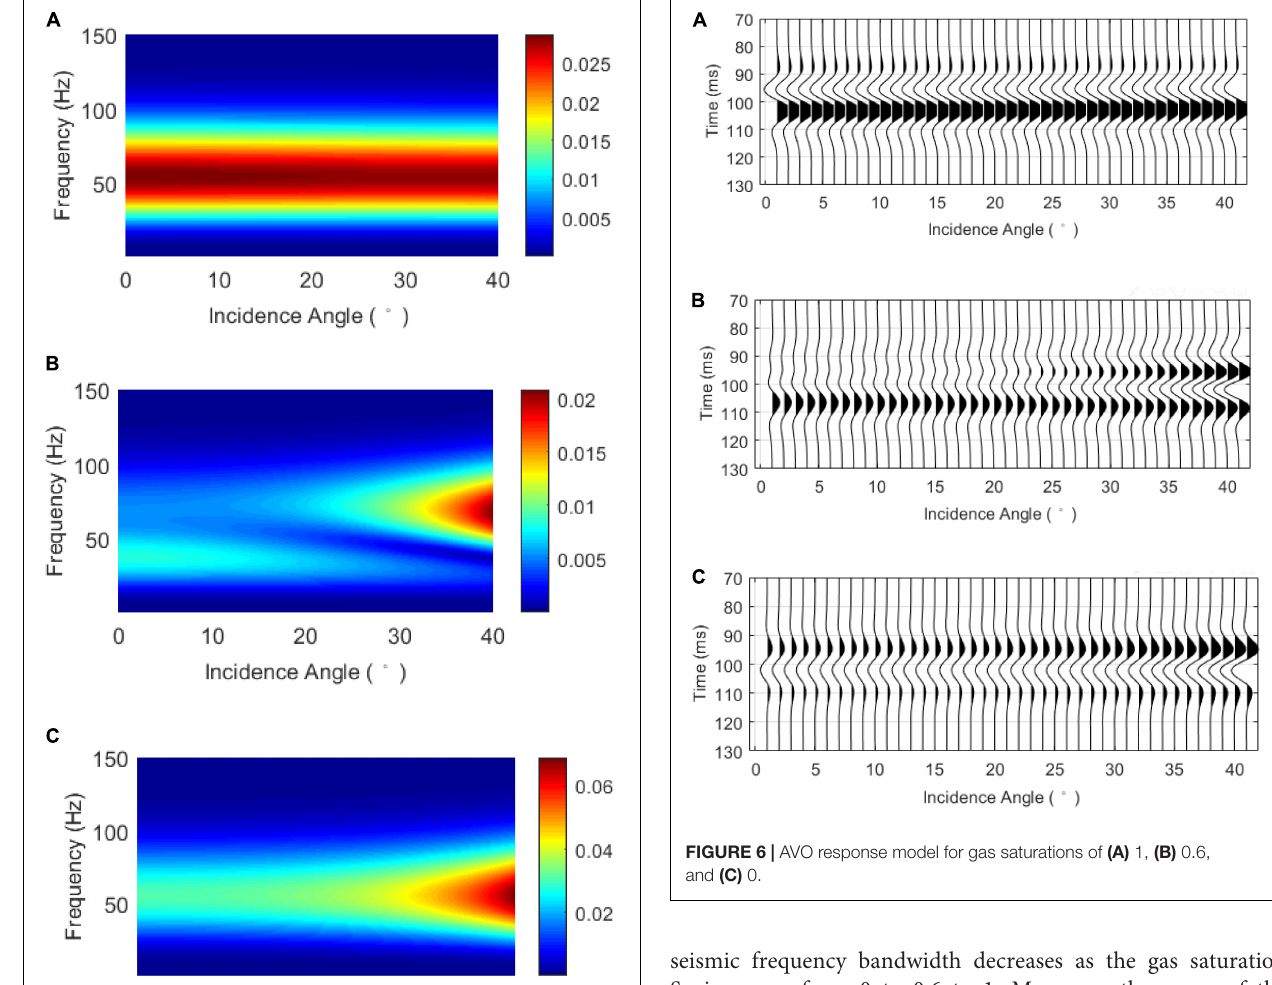
seismic frequency bandwidth decreases as the gas saturation Sg increases from 0 to 0.6 to 1. Moreover, the range of the frequency at which the velocity dispersion occurs moves to a higher frequency. Accordingly, as illustrated in Figure 2B , the attenuation peak also moves to a higher frequency as Sg